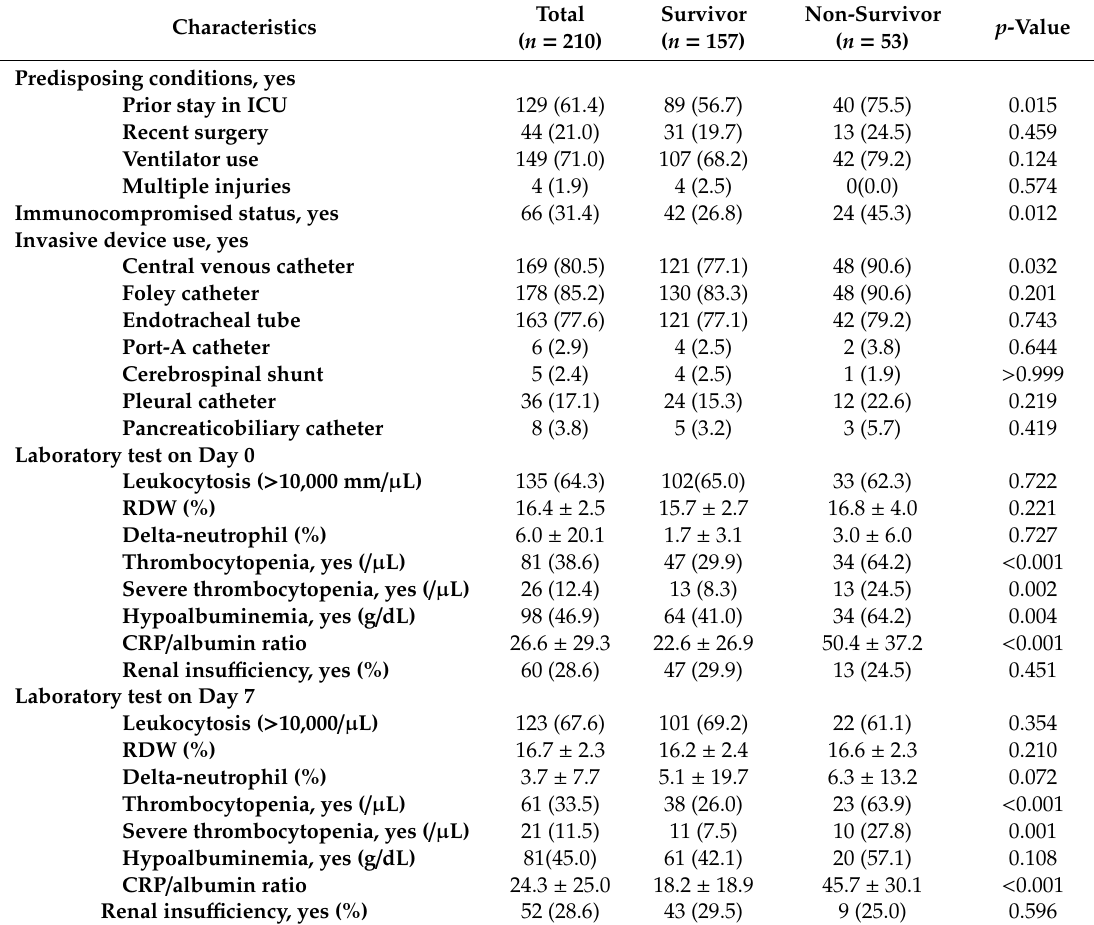
Table 2. Comparisons of clinical conditions and laboratory data between survivors and